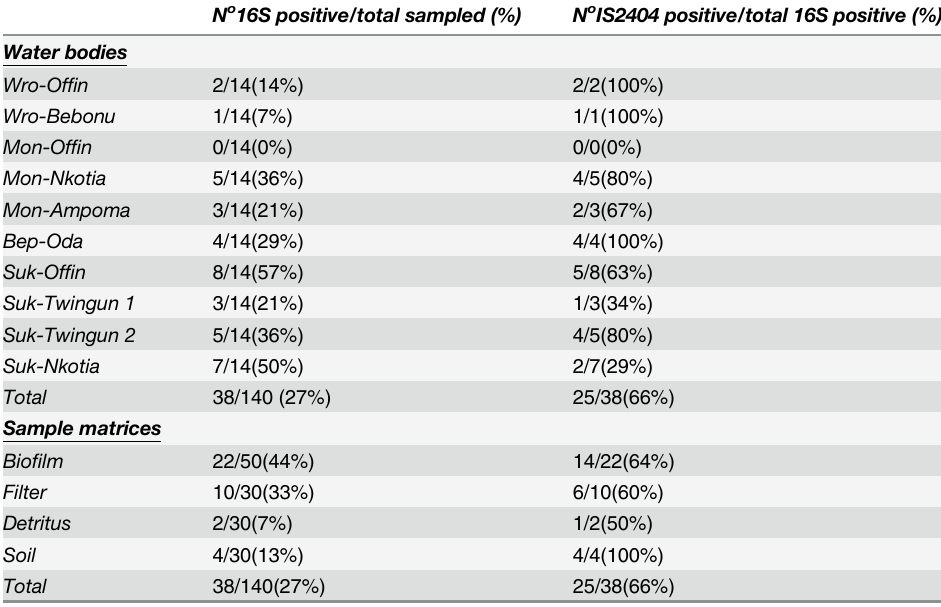
Environmental samples were fi rst screened for mycobacterial 16s rRNA positivity. Positive samples were then screened for IS2404. At each water body, bio fi lm were collected in quintuplicates. All other samples were collected in triplicates. Bio fi lm were the most positive, (22/38) for 16S and this difference in matrix positivity was statistically signi fi cant (P = 0.0007) using the Chi-square contingency table for